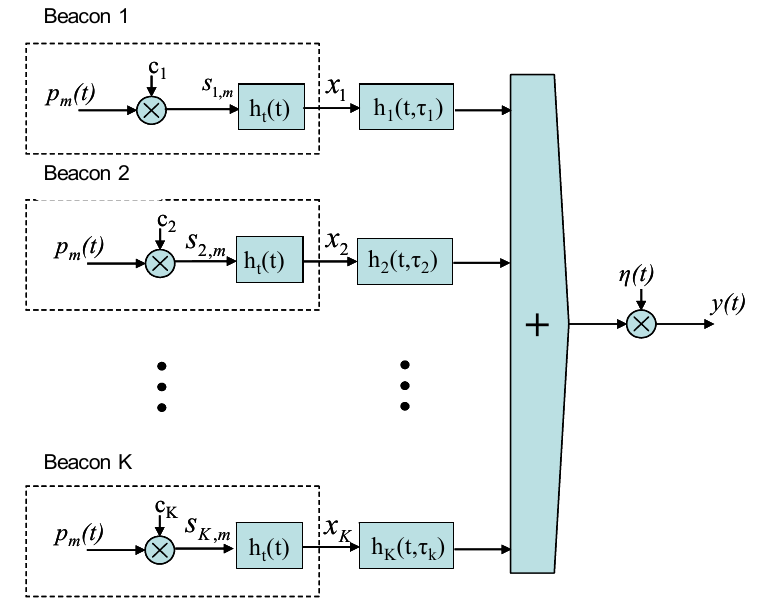
Figure 3. Block diagram of the proposed positioning system